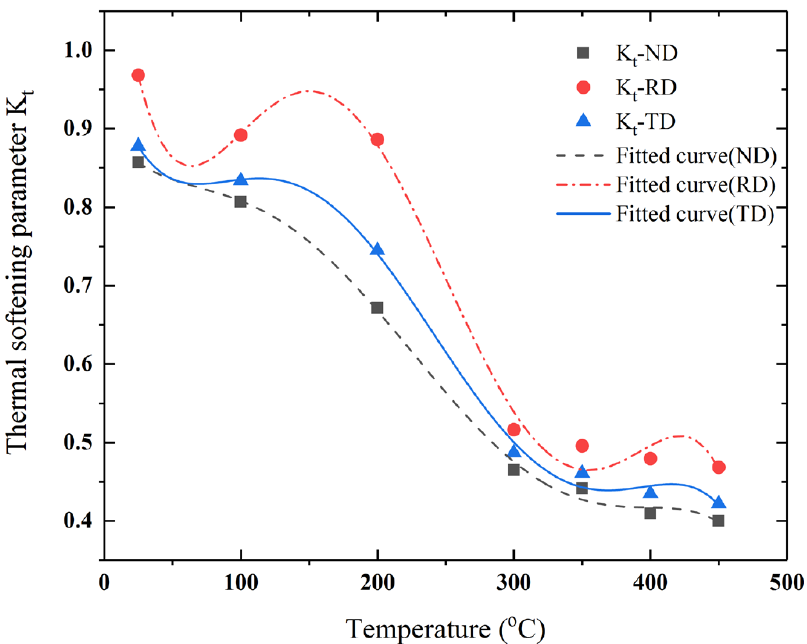
Figure 8. Fitting curves of the thermal softening coefficient for different directions with a strain rate 4 s − 1 of 0.4 × 10 4 s − 1 . of 0.4 × 10